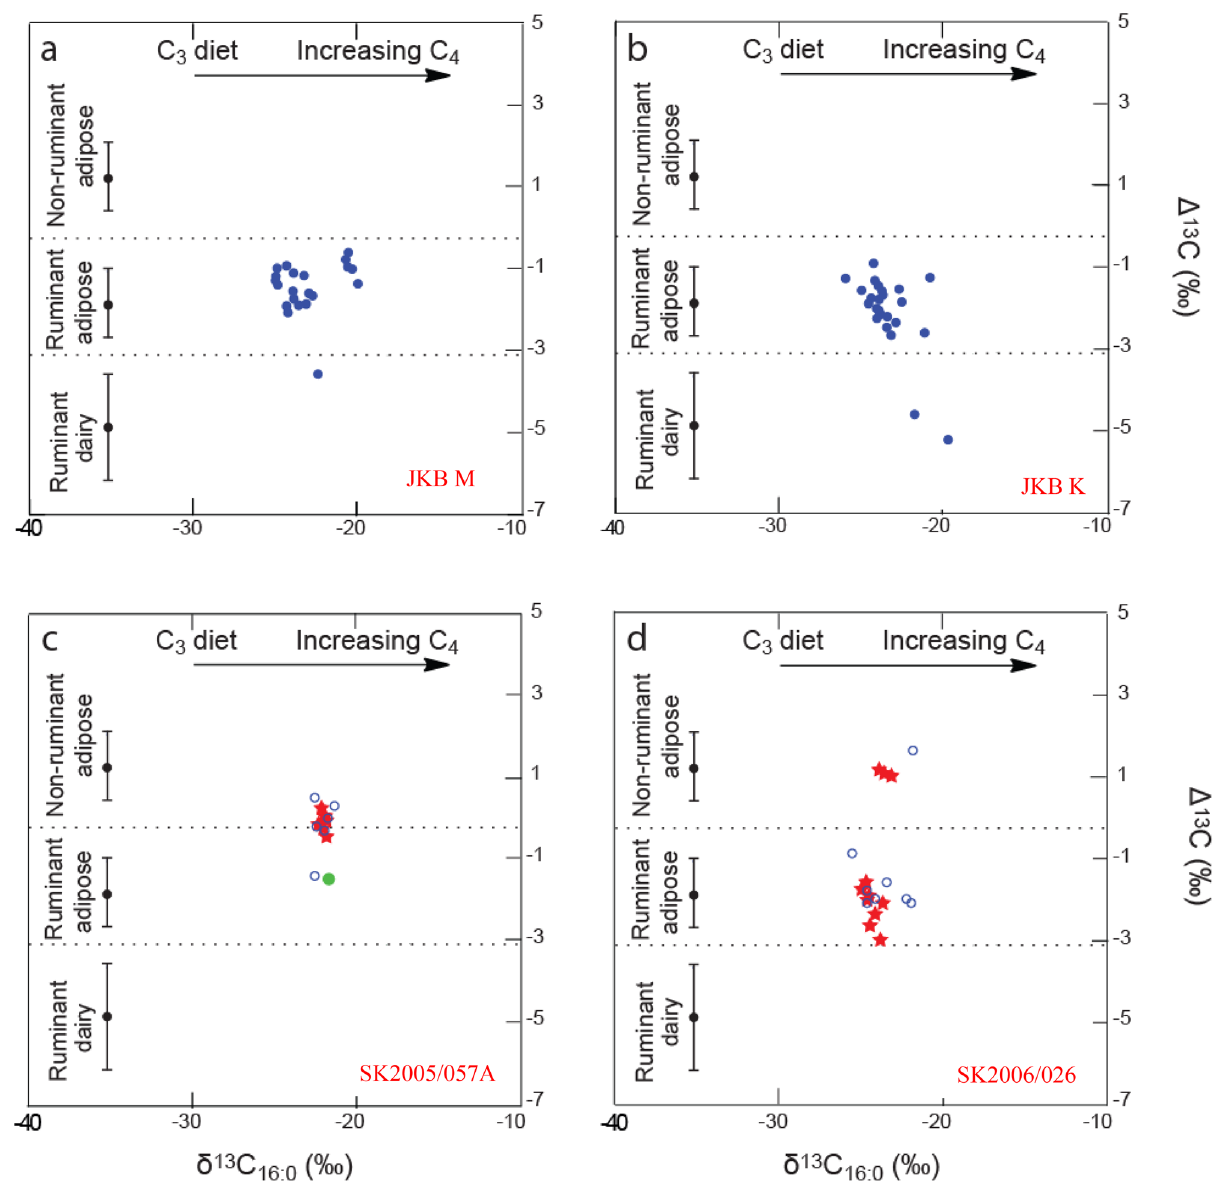
Figure 4. Graphs showing the Δ 13 C (δ 13 C 18:0 –δ 13 C 16:0 ) values from the Namaqualand potsherds by individual site. Datapoints shown as blue (filled circles in a and b and unfilled circles in c and d ) indicates the processing of terrestrial animal fats and red stars indicate where APAAs of carbon chain length C 18 –C 22 and isoprenoid acids (indicating marine resource processing) were also observed in the residue. The green dot indicates the external residue analysed. The ranges shown here represent the mean ± 1 s.d. of the Δ 13 C values for a global database comprising modern reference animal fats from Africa 75 , UK (animals raised on a pure C 3 diet) 41 , Kazakhstan 76 , Switzerland 77 , and the Near East 78 published